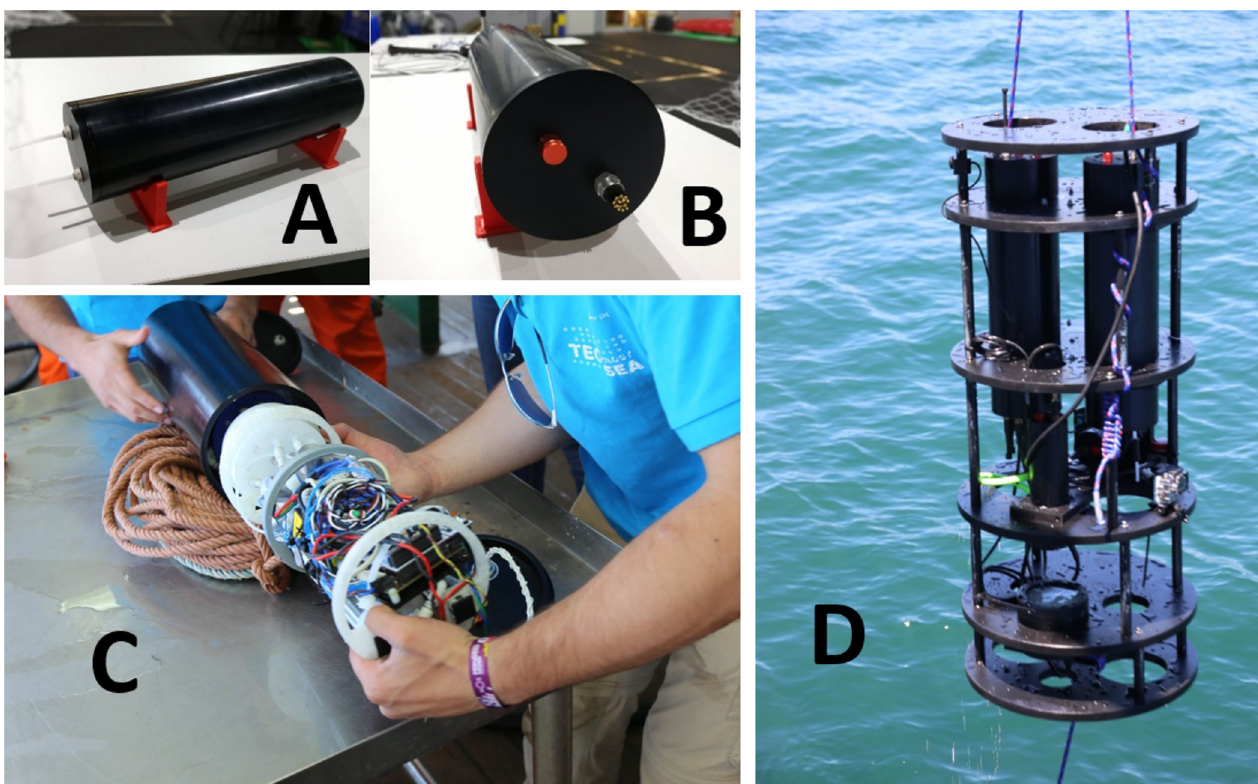
Fig 9. In situ autonomous biosampler (IS-ABS) prototype. Water inlet/outlet (A); external connector interface (B); opened in the field (C); integrated in a multi-sensor system.